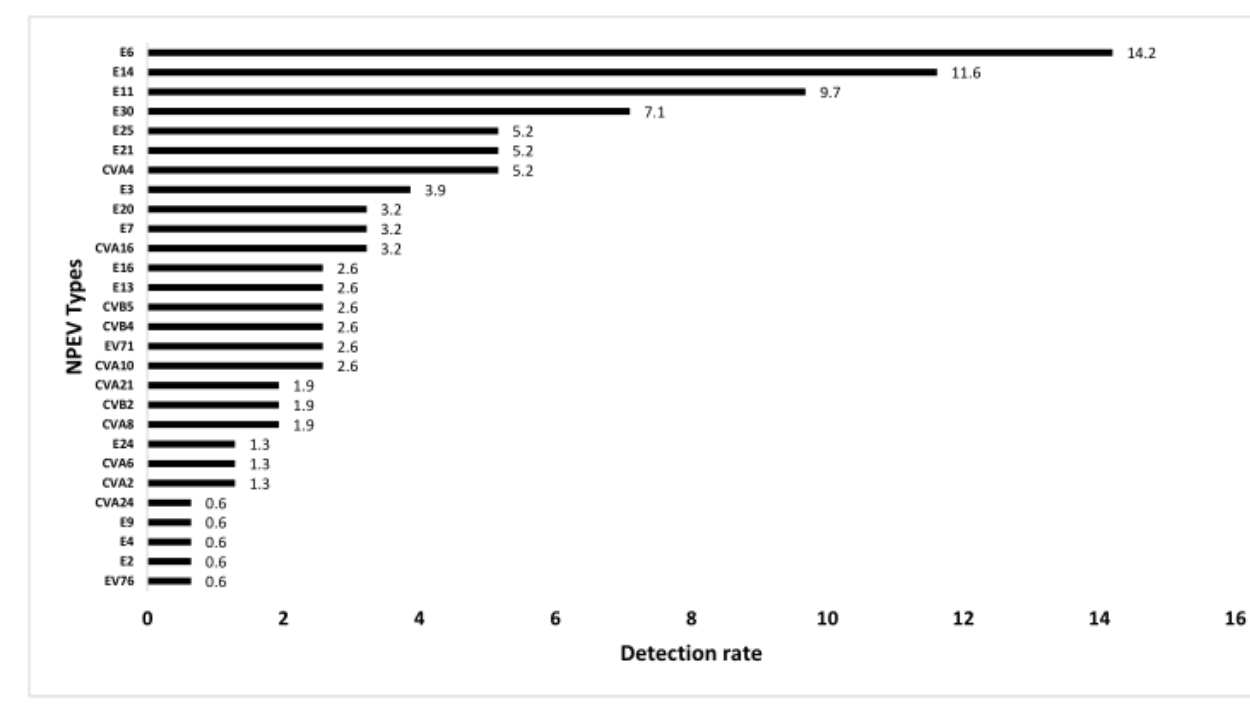
Figure 1. Detection rates of NPEV types. Table 3. Distribution of polioviruses identified per clinical status and per year.